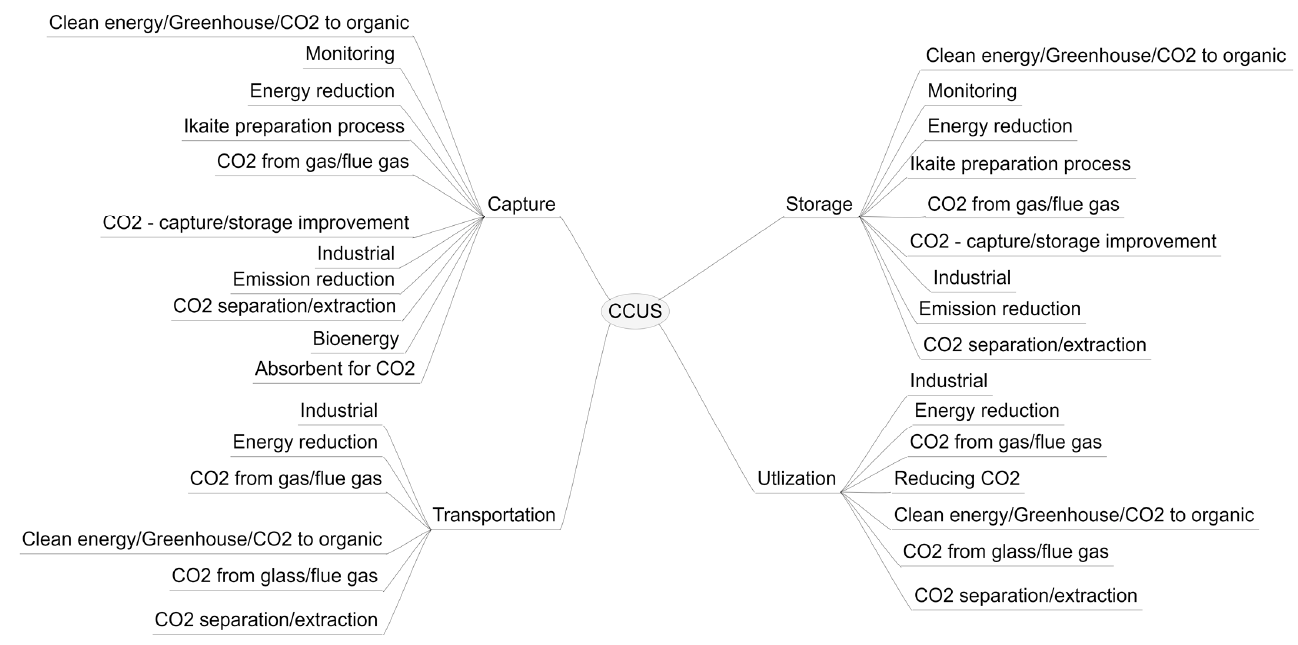
Figure 2. Schema (1) CCUS primary classification.